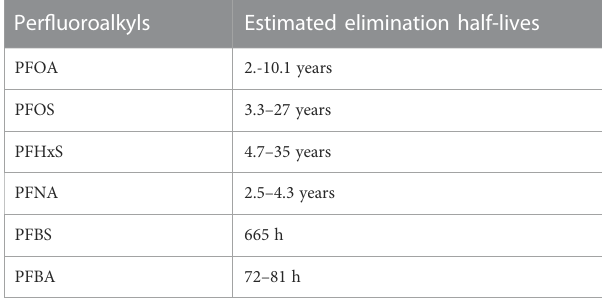
TABLE 2 Estimated elimination